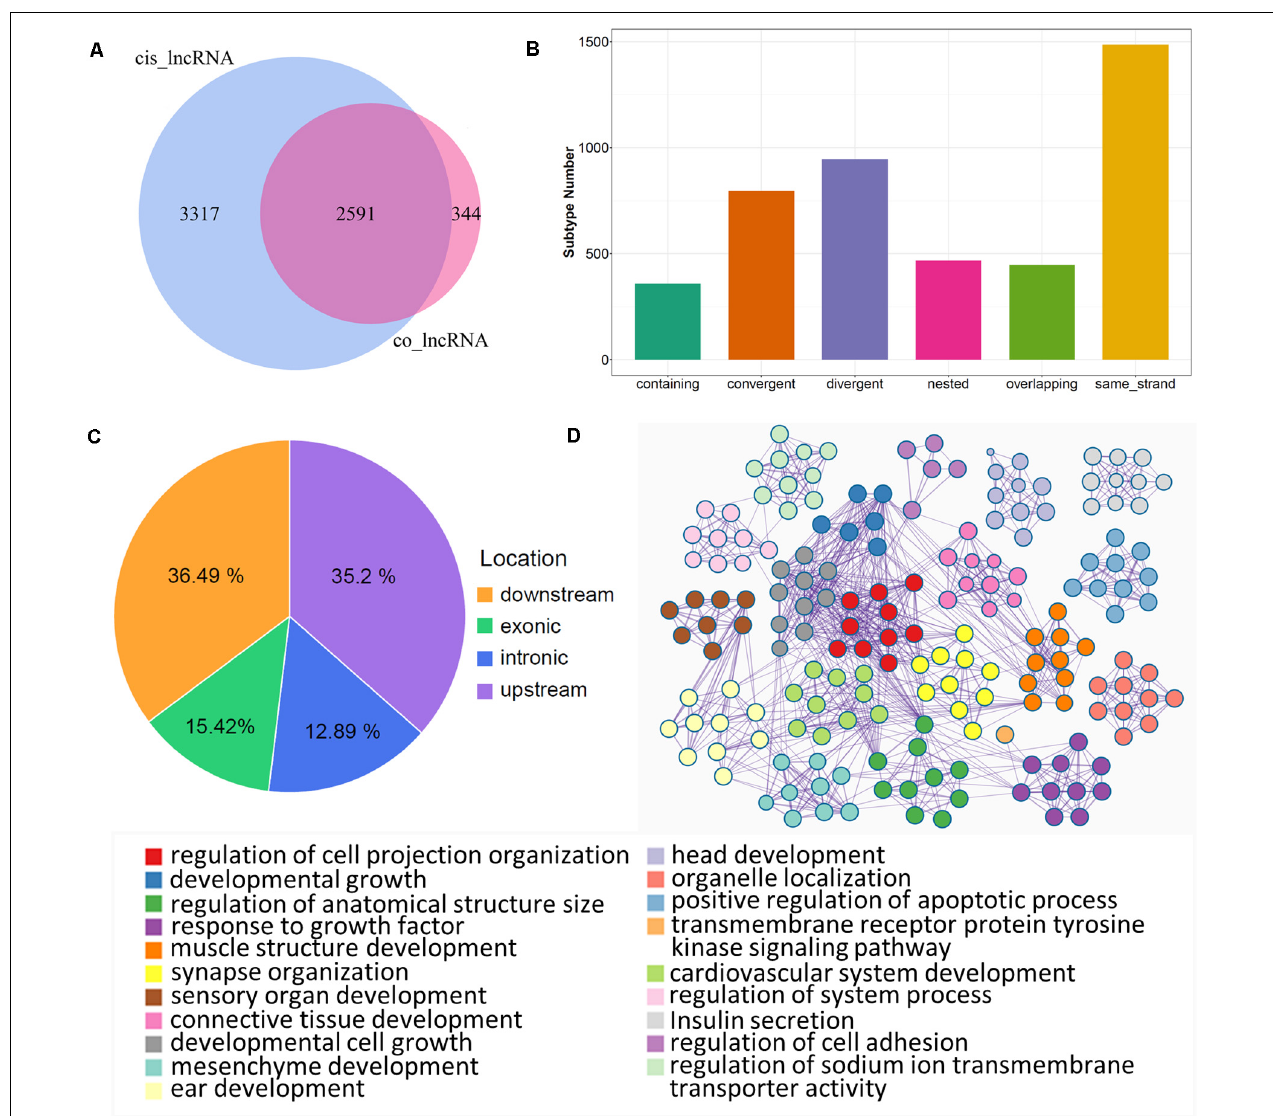
FIGURE 4 | Cis -regulation of lncRNAs with target genes. (A) Venn plot of unique lncRNAs in cis -regulation with co-expressed lncRNAs; common region references to key cis -lncRNAs. (B) Subtype statistics of key cis -regulatory lncRNAs. According to the illustration, “Genic” includes the subtypes of “overlapping,” “containing,” and “nested”; “Intergenic” consists of “same strand,” “convergent,” and “divergent” subtypes. (C) Genome location statistics of key cis -regulatory lncRNAs. (D) Functional enrichment analysis of cis -genes under control of key cis -lncRNAs; similar clusters are annotated with the same color, node size represents gene number in term, and a line of inter-clusters indicates a common